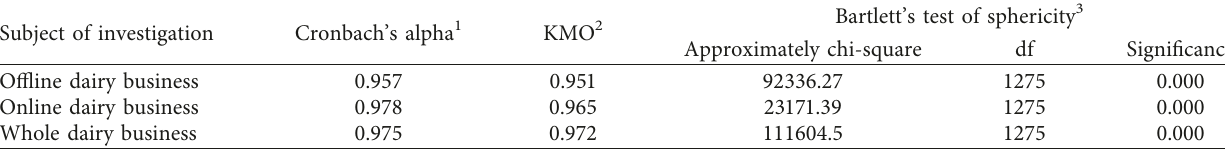
Table 6: Test of reliability and validity.